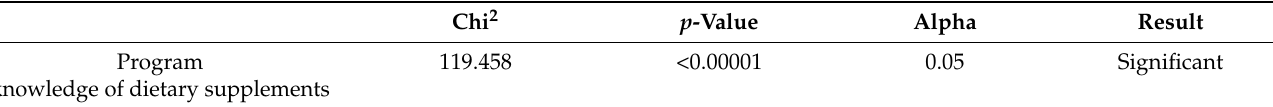
Table 4. Correlation between program and knowledge of the DSs.